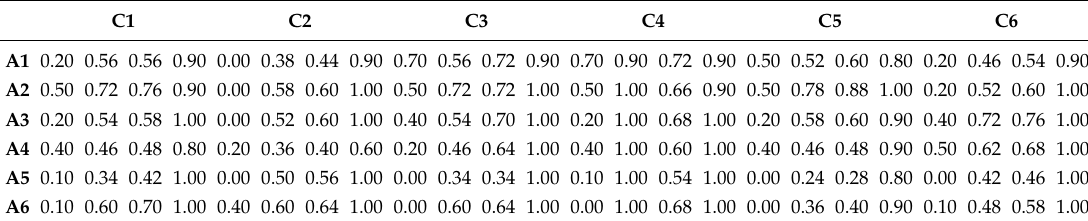
Table 9. Normalized fuzzy decision matrix.